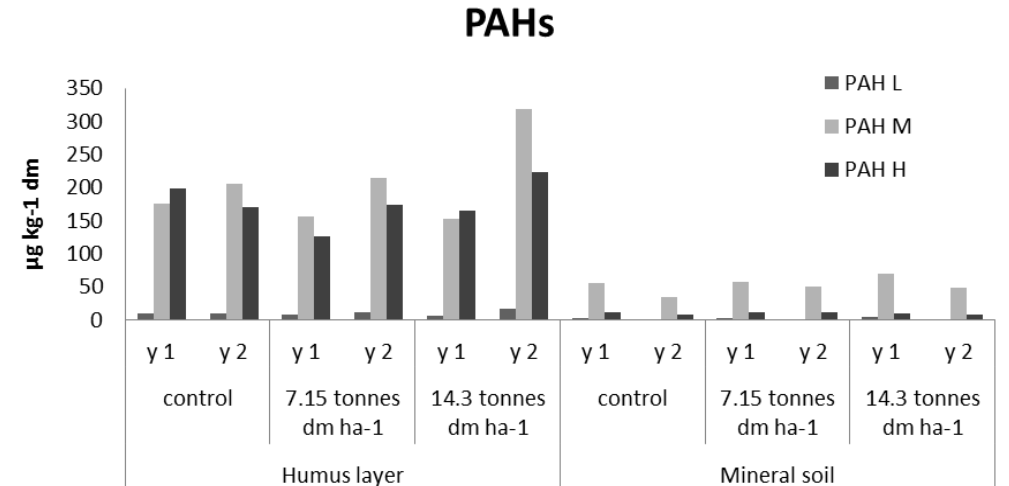
Figure 4. PAH levels in the small-scale experimental sites fertilized by hand